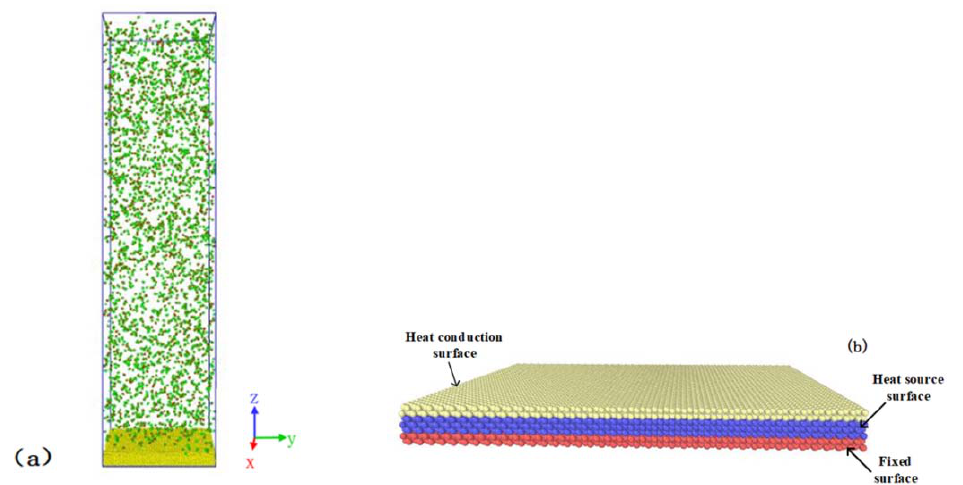
Figure 1. Configuration of the simulation systems. ( a ) Condensation of water molecules on the surface; ( b ) the structure of the surface for condensation.